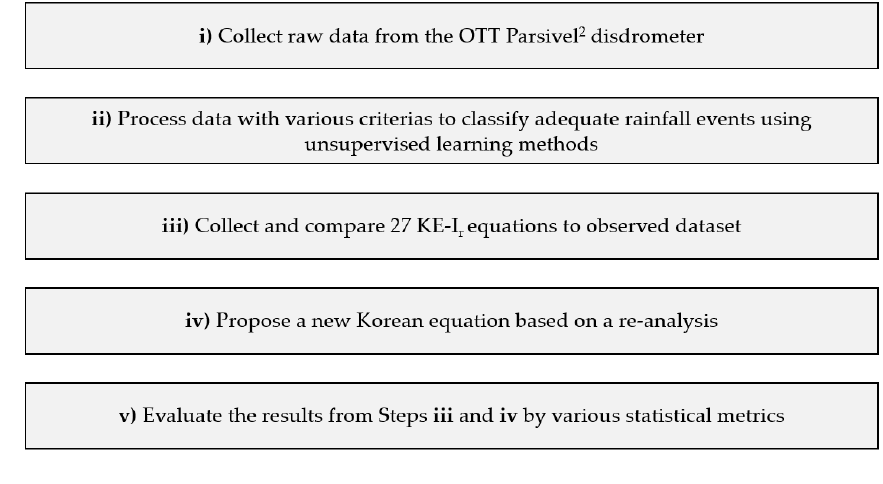
Figure 2. ( a ) Functional principle of the Parsivel 2 disdrometer (Source: Operating instructions Pre- sent Wether Sensor OTT Parsivel 2 [35]) and ( b ) the Parsivel 2 located inside the Kyungpook National University, Sangju campus.